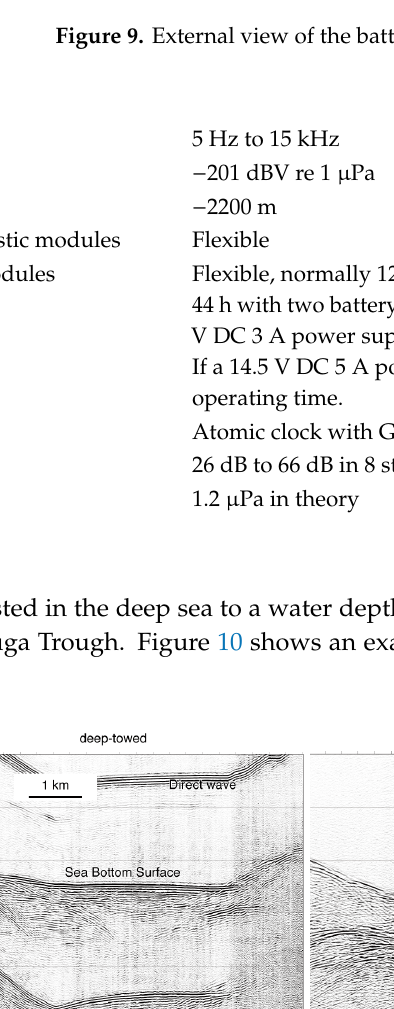
Figure 10. Comparison of the reflection images obtained by new system with surface-towed cable, which is same scaled profiles. For these data, the depth of the sea bottom is about 1350 m, and towing depth of the streamer is about 600 m. The sound source that was used was a mini-GI gun system (Sercel Inc., Houston, TX, USA), and the volume of both the generator and the injector were 491.6 cm 3 . Figure 10 shows that the comparison of the reflection images, obtained by this new system, with the existing surface-towed cable. Processing the deep-towed data was carried out using depth correction, 30 to 200 Hz band-